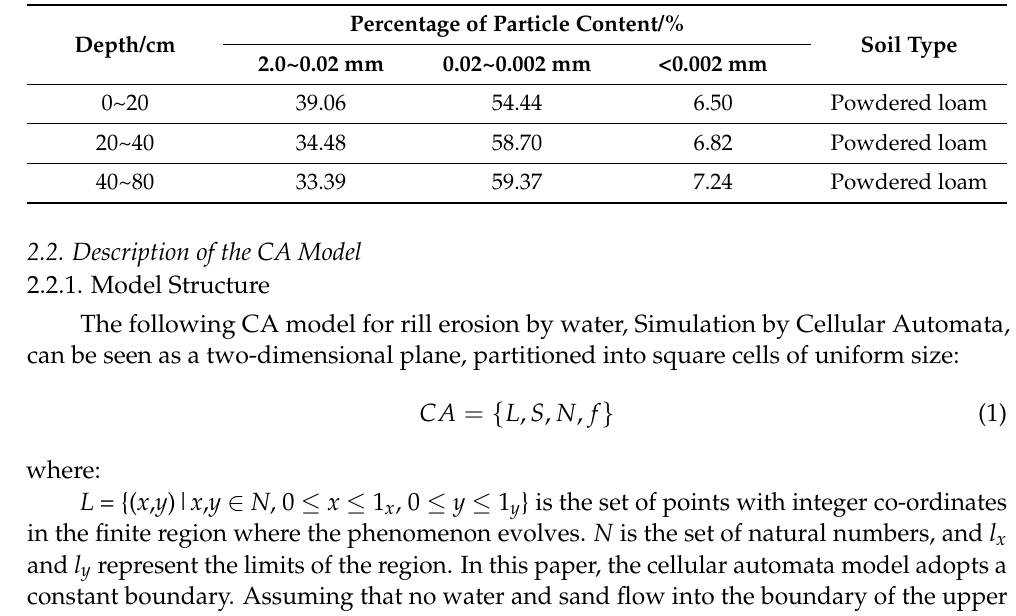
Table 1. Mechanical composition of the soil under